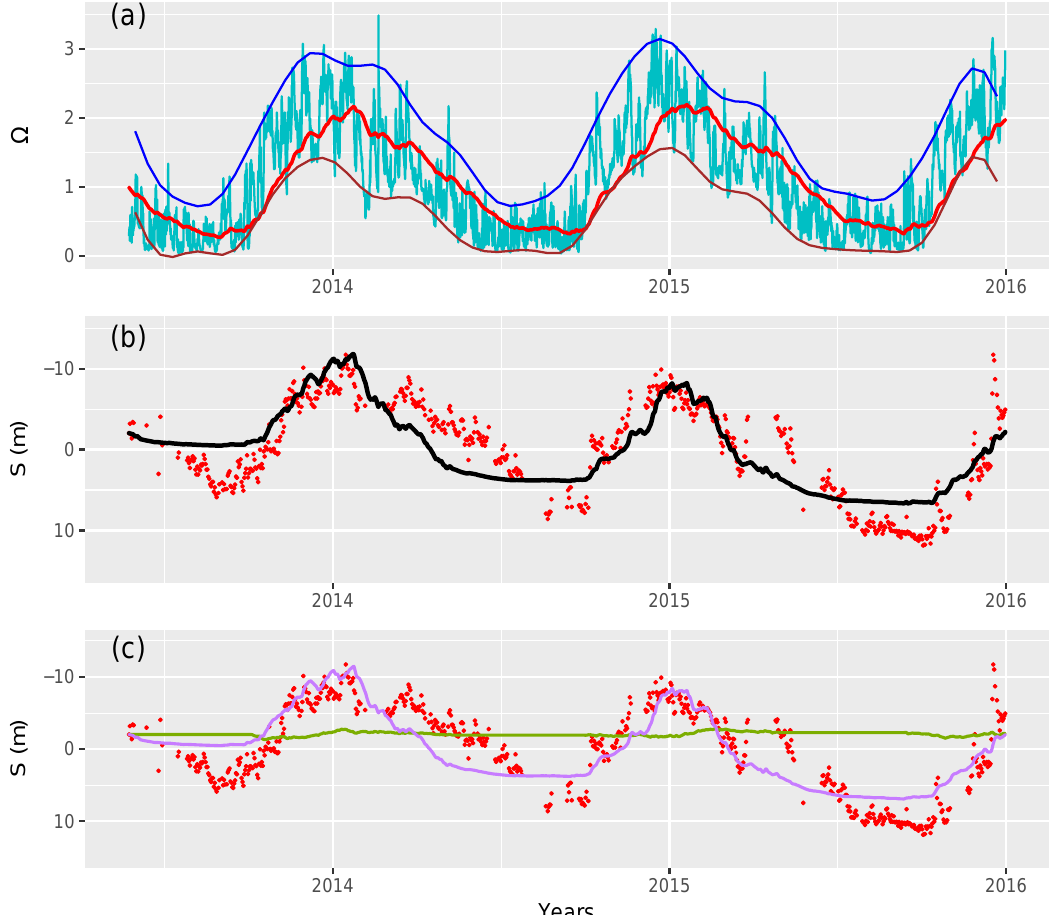
Figure 10. The combined model calibrated with DS 2 . ( a ) Time series of Ω (green line), Ω eq (red line), upper envelope (blue line), lower envelope (brown line) and inter-annual average (black line), ( b ) Time series of measured shoreline position (red points) and shoreline position from combined model (black line), ( c ) Cross-shore contribution (purple line), longshore contribution (green